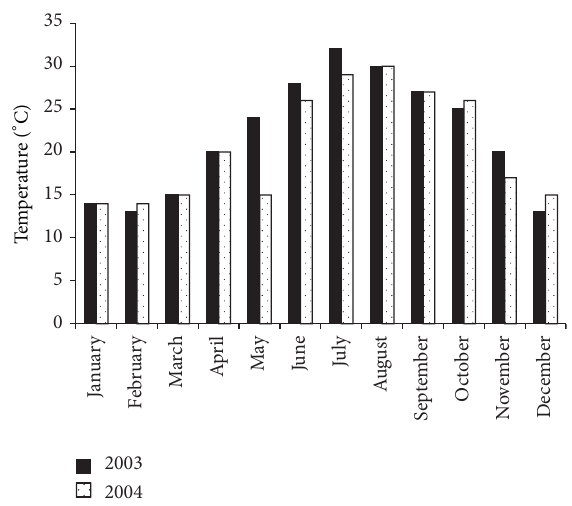
Figure 1: Monthly mean temperatures ( ∘ C) registered at the exper- imental site in 2003 and